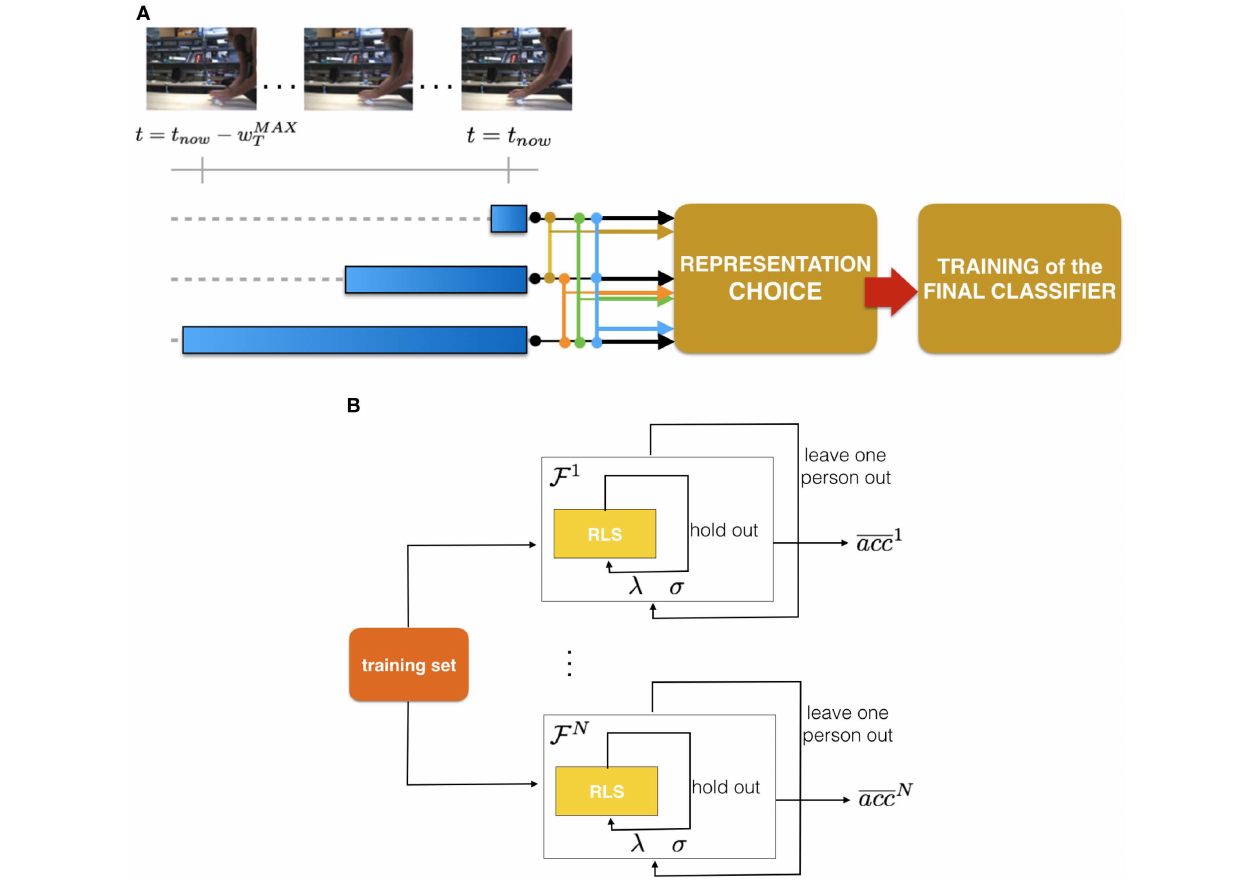
FIGURE 2 | (A) A visual sketch of our pipeline. From left: in each image of a sequence we detect the moving region and compute the features. We then compute a running average of those features over different temporal windows (3 in this example, identified by the blue ranges). Then, we evaluate different temporal models which may be composed of more than one temporal resolution and select the most appropriate. (B) A visual sketch representing the core procedure of our model